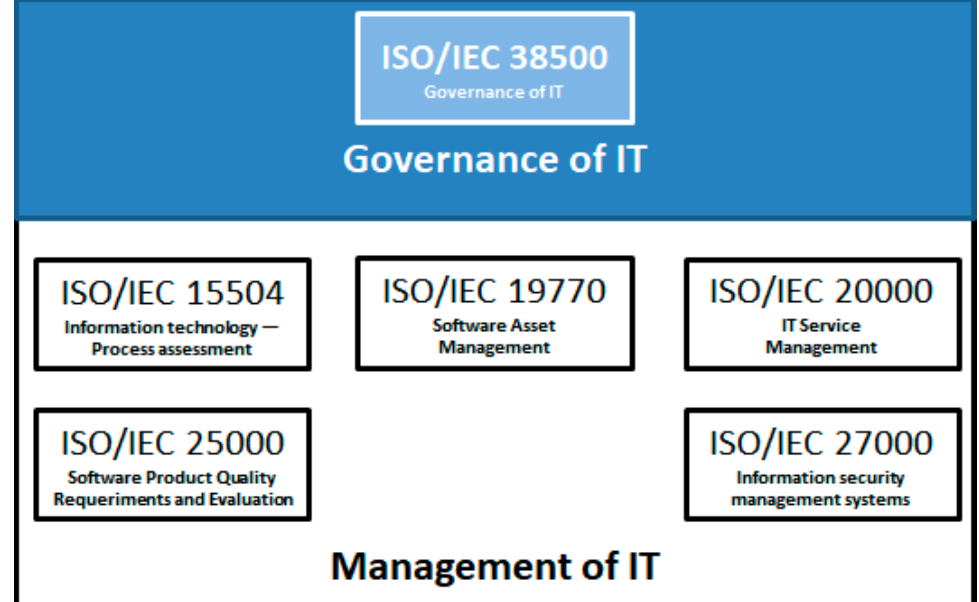
Figure 2. ISO/IEC IT Governance and main IT Management standard scopes (as appears in Juiz and Toomey [3]), ISO/IEC 38500 model (own elaboration from Juiz and Toomey [3]), ISO/IEC IT Gov- ernance and main IT Management standard scopes (own elaboration from Juiz and Toomey